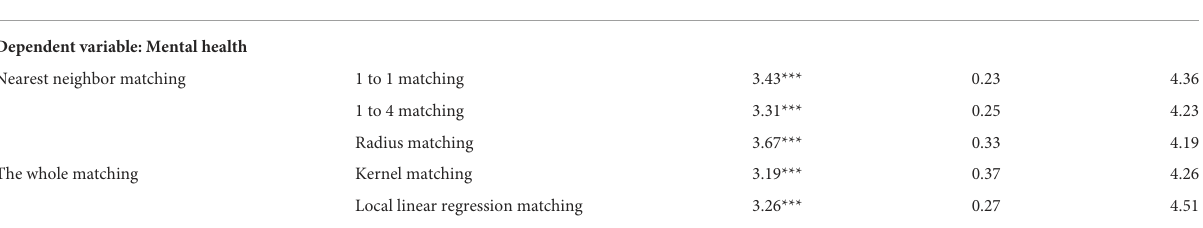
TABLE 4 Propensity score matching results